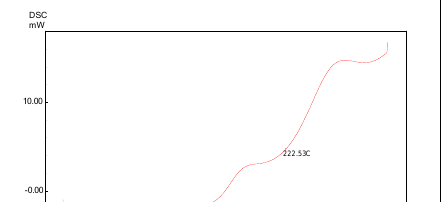
Figure 8: DSC curve of Mg.St.